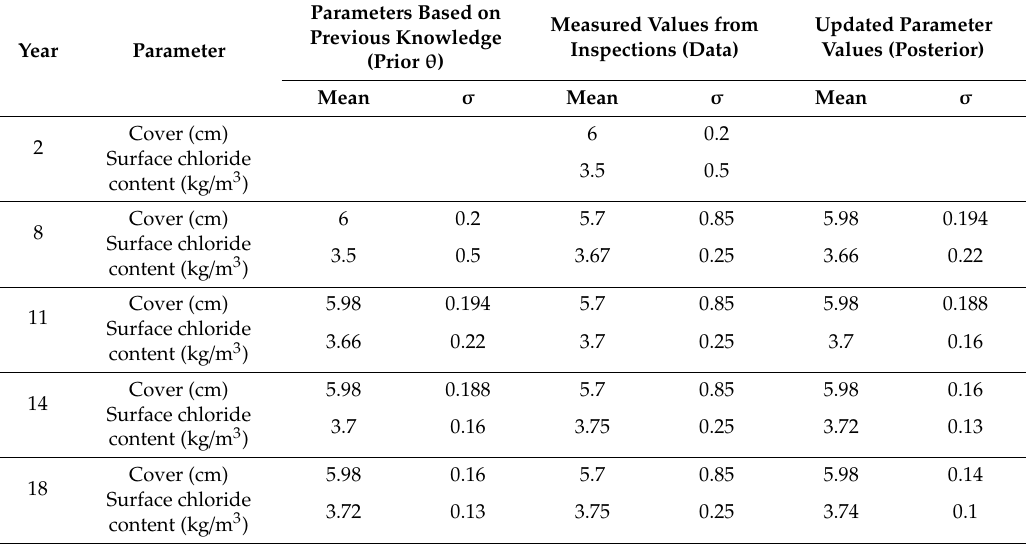
Table 8. Parameters used in Stage 1 and Bayesian